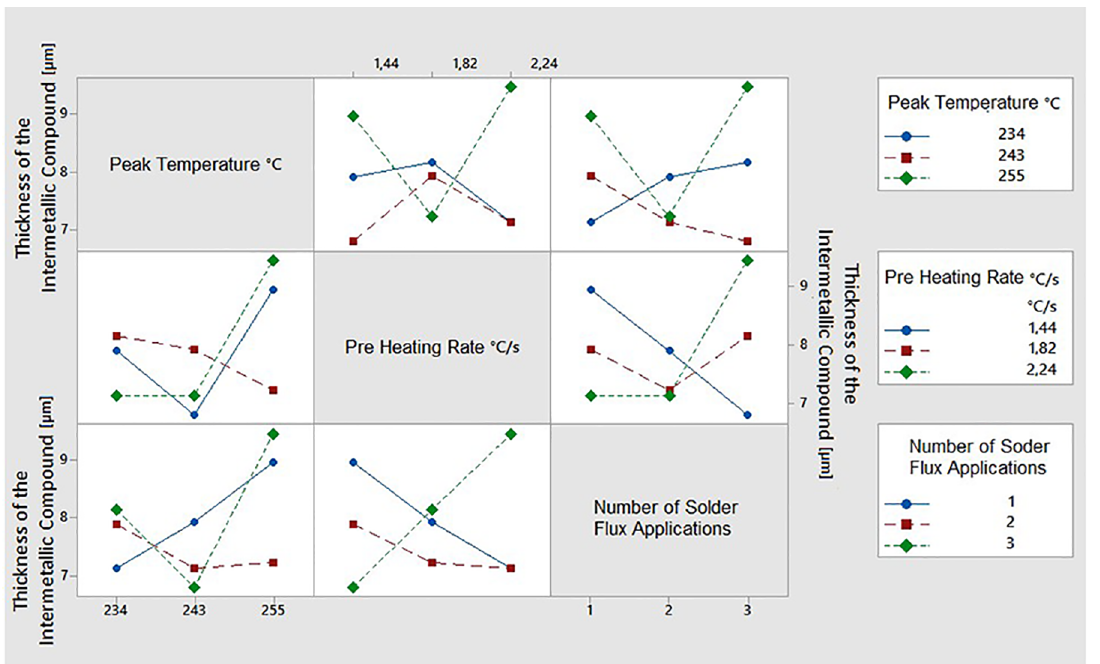
Figure 7. Interactions for the thickness of the intermetallic